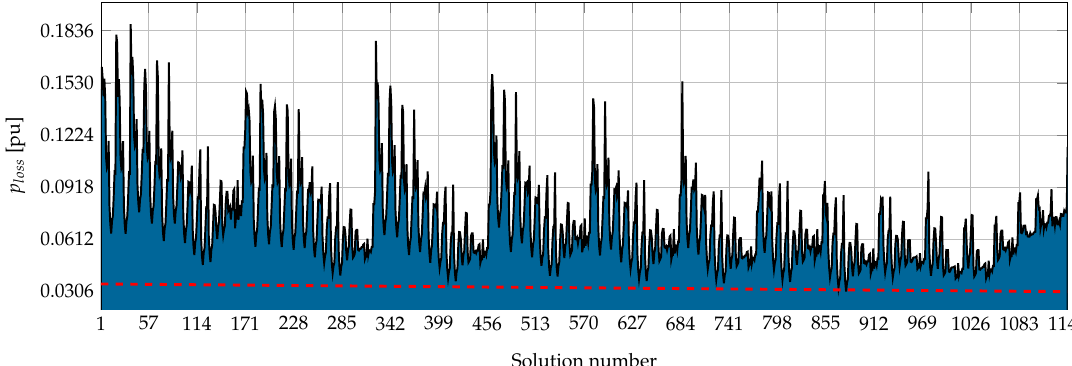
Figure 7. Solutions reached by the exhaustive evaluation in the 21-node test